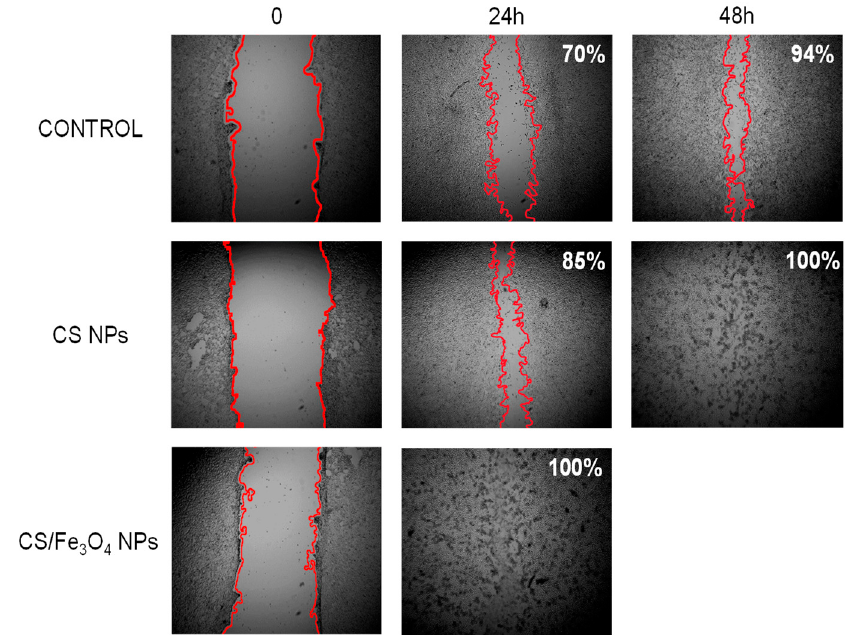
Figure 6. Hybrid NPs accelerated migration of fibroblast in scratch assay. Positive control at 0 h, 24 h and 48 h versus CS NPs (33.75 µg/mL) at 24 h and 48 h versus CS/Fe 3 O 4 NPs (33.75 µg/mL) at 24 h. The red lines indicate the fronts of migrating cells, and the percentage indicates the healed area.